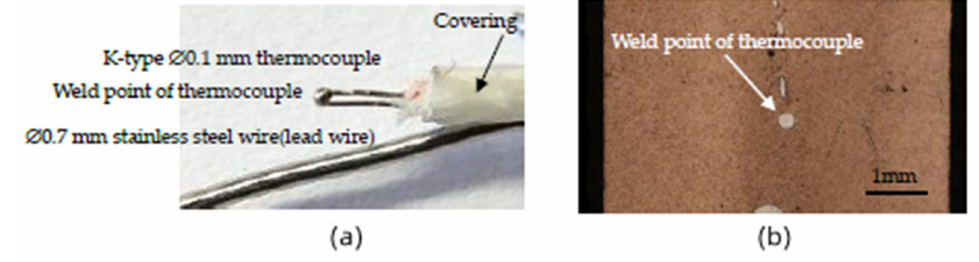
Figure 2. ( a ) Tip of thermocouple and lead wire; ( b ) thermocouple inserted into strip.